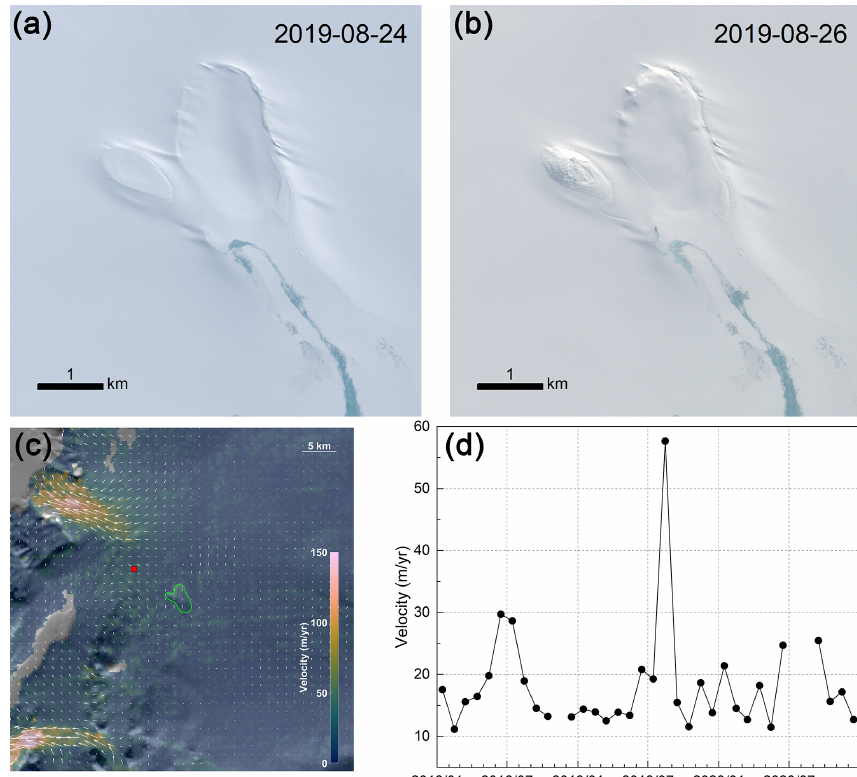
Figure 6. Sentinel-2 optical imagery of the collapse basin and ice surface velocity around it. Panels (a) and (b) are the images showing the obvious surface lowering between 24 and 26 August 2019. (c) The velocity map of September 2019 overlain on MODIS Mosaic of Greenland (MOG) 2015 image maps (Haran et al., 2018). The red square indicates the region of velocity averaging for the velocity time series shown in (d) . The green polygon represents the boundary of the collapse basin. The white velocity vectors show the direction and magnitude of horizontal velocity. (d) The velocity time series between 2018 and 2020. Each dot represents a monthly average velocity derived from MEaSUREs dataset. Note that data gaps exist due to lack of valid data in that month. Dates are given in the format yyyy-mm-dd (a, b) and yyyy/mm (d)